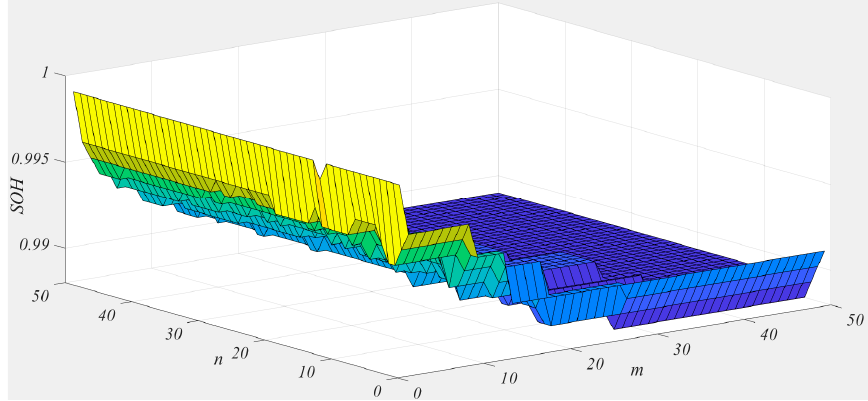
Figure 4. The changing trend of topology 1 battery pack state of health ( SOH) affected by C 0 .